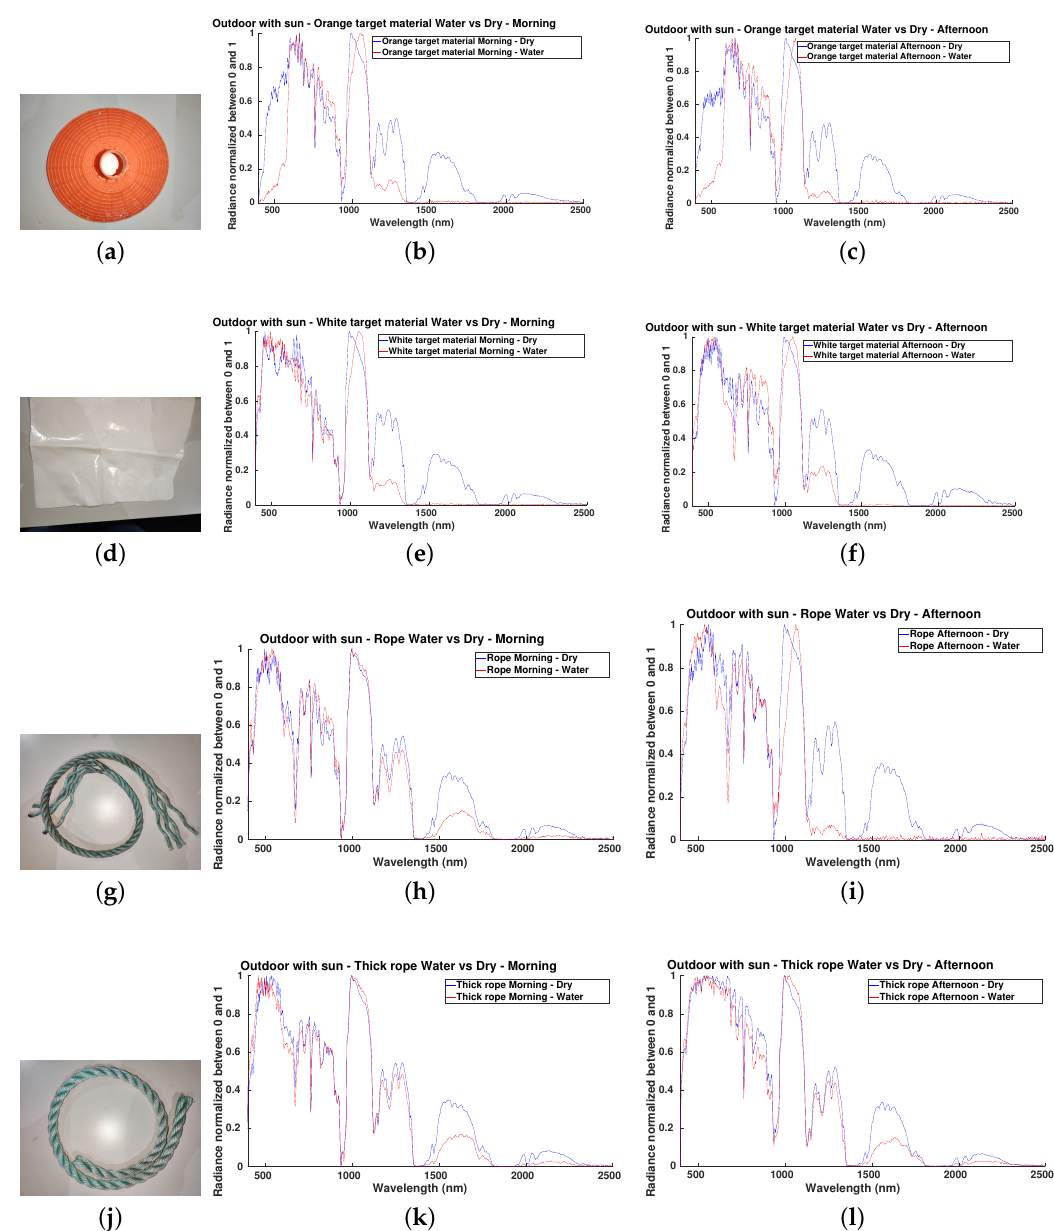
Figure 7. Plastics used in the targets and the laboratory results in normalized radiance for each target material: ( a ) shows the orange target material (with approximately 20 cm diameter), ( b , c ) shows the laboratory results for the orange target material, respectively; ( d ) shows the white target material (with approximately 50 cm width, with variable length), ( e , f ) shows the laboratory results for the orange target material, respectively; ( g ) shows the thin rope target material (3 cm diameter, with variable length), ( h , i ) shows the laboratory results for the orange target material, respectively; ( j ) shows the thick rope target material (5 cm diameter, with variable length), ( k , l ) shows the laboratory results for the orange target material,